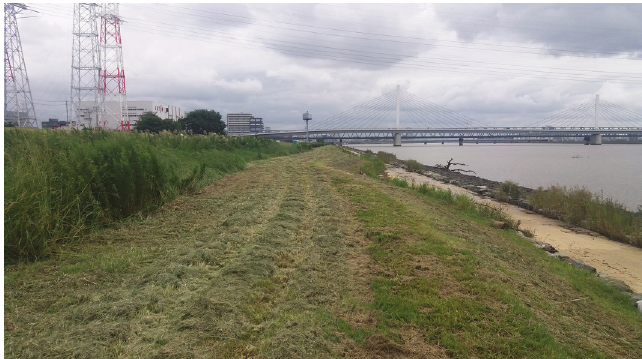
Fig. 3. Arakawa super levee in Tokyo. Grassland is left uncut to produce a mosaic of habitats for Orthoptera. Photo by T. Gardiner.